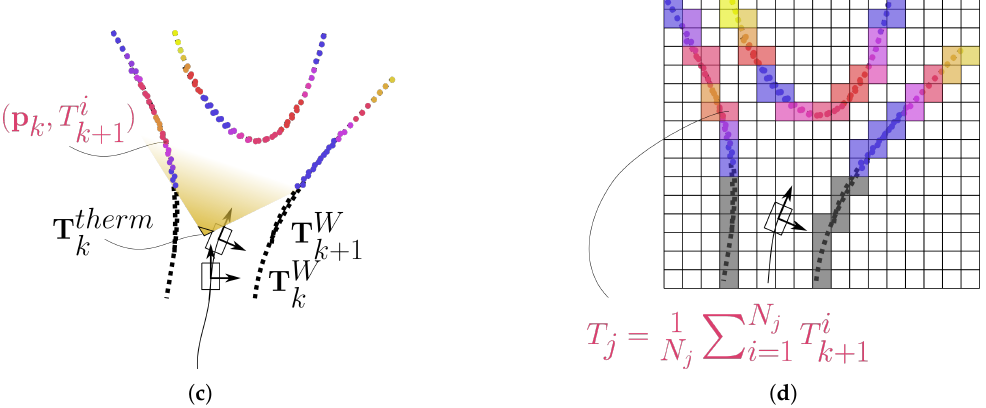
Figure 5. ( a ) Acquisition of the point clouds by the LiDAR while the rover is moving. Each set of points is initially expressed in its own reference frame. ( b ) Reconstruction of the trajectory by the LiDAR SLAM (LOAM) algorithm. The motion estimation T L provided by the odometry function is k combined with the rover positioning T W determined by the mapping function to register the new k point cloud Q k + 1 (blue coloured) on the current map, returning the 3D transformation T W which k + 1 adds a new segment to the reconstructed trajectory. ( c ) After the data fusion has been performed, the sequence of transformations T W is used to align the thermal point clouds (rainbow coloured), 1... N before they are merged together. ( d ) The registered and merged thermal point clouds are then discretized with a 3D grid (here shown in section) by an OcTree -based spatial decomposition function. In the end, each cell is associated with the average temperature of the points it contains, producing a temperature distribution